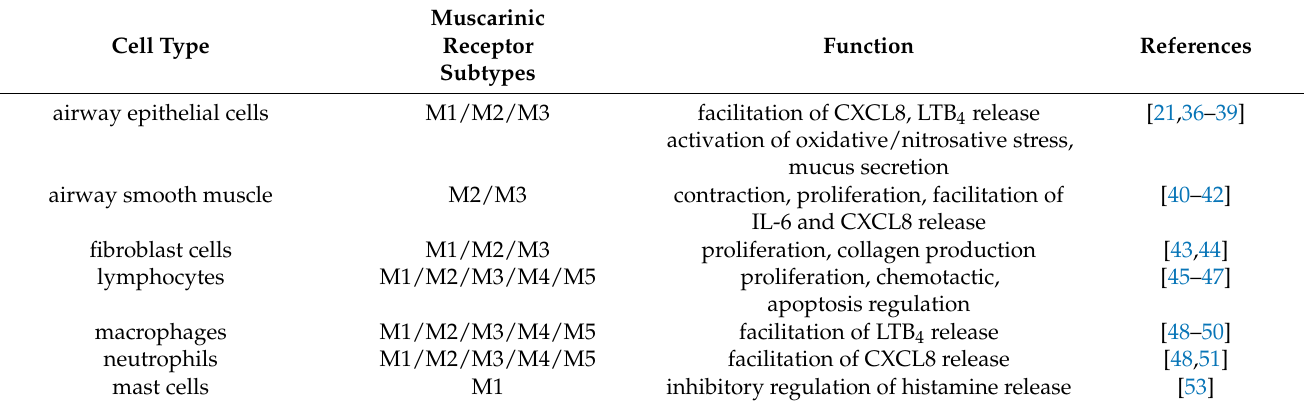
Table 1. The effects of mAChRs on structural cells and immune cells in the human